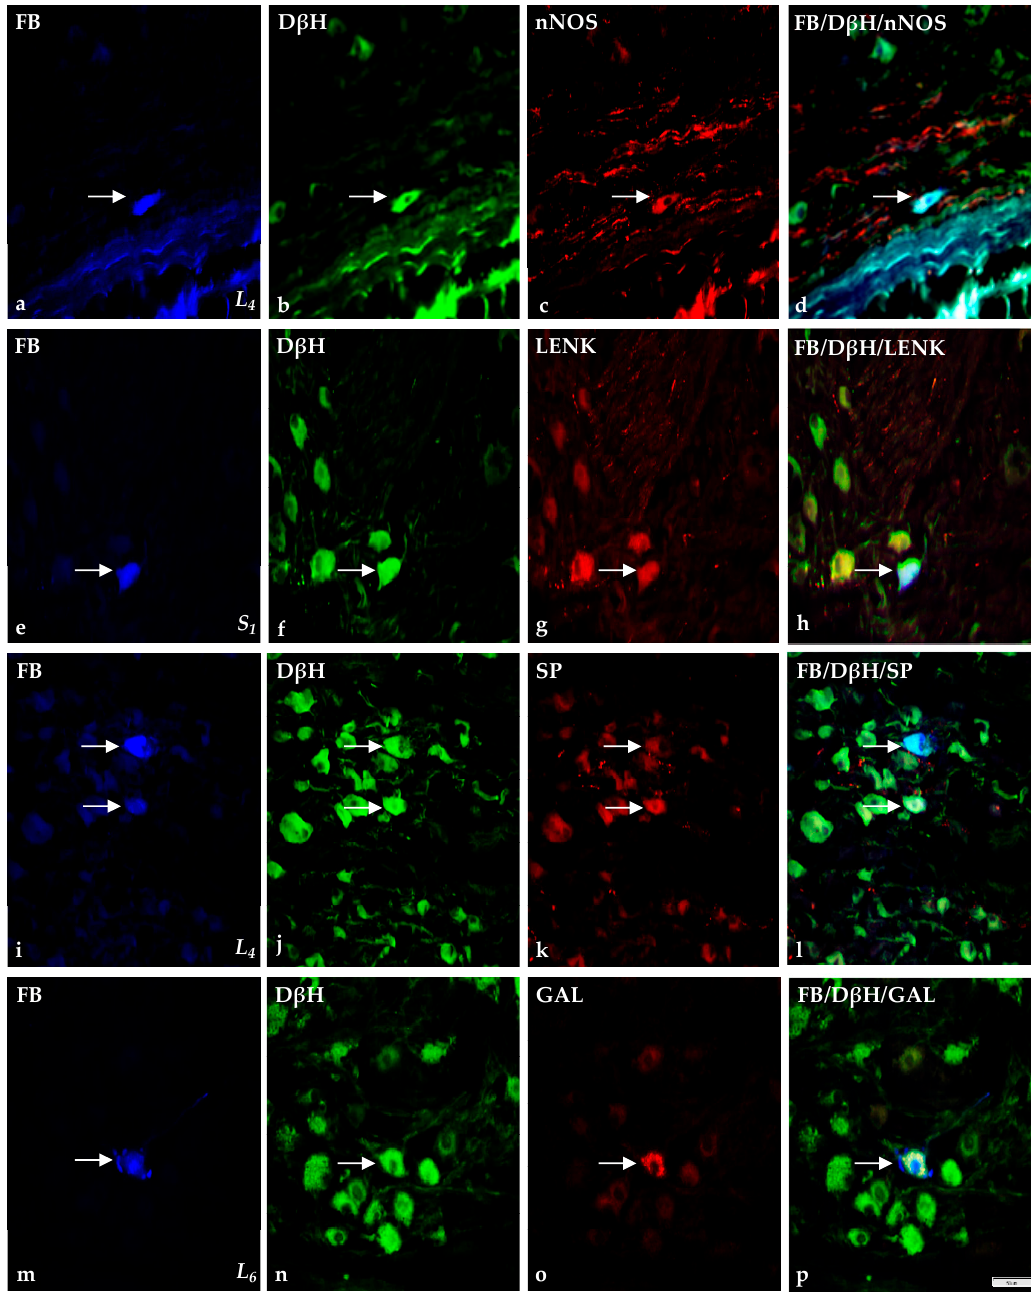
Figure 6. Representative images of sympathetic chain ganglia skin-projecting neurons in porcine skin hind leg. The arrow indicates Fast blue-positive (FB + ) skin perikaryon containing examined substances. All the images are showed separately from blue (FB-positive ( a , e , i , m )), green (D β H-positive ( b , f , j , n )) and red (positive for nNOS ( c ); LENK ( g ); SP ( k ); and GAL ( o )) fluorescent channels. Microphotographs d , h , l , p showing the over position of all three channels simultaneously. In L 4 ganglion FB + neurons ( a , i ) which were simultaneously D β H + ( b , j ) as well as nNOS + ( c ) and SP + ( k ). Visible one FB + perikaryon ( e ) containing D β H ( f ) and LENK ( g ) in S 1 SChG. In L 6 ganglion FB + neurons ( m ) which were simultaneously D β H + ( n ) as well as GAL + ( o ). Scale bar = 50 µm.